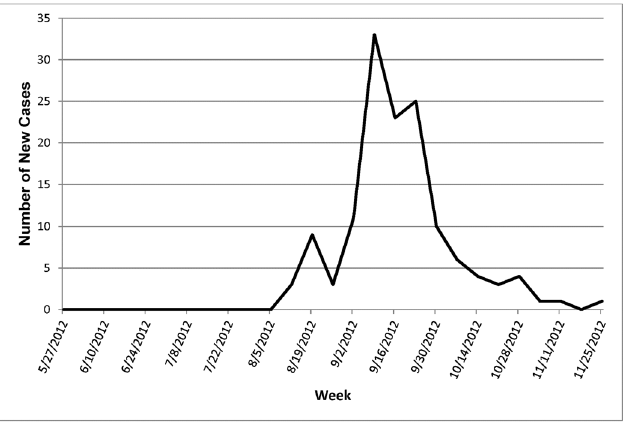
Fig 2. Number of new EHD cases in cattle and bison by week.